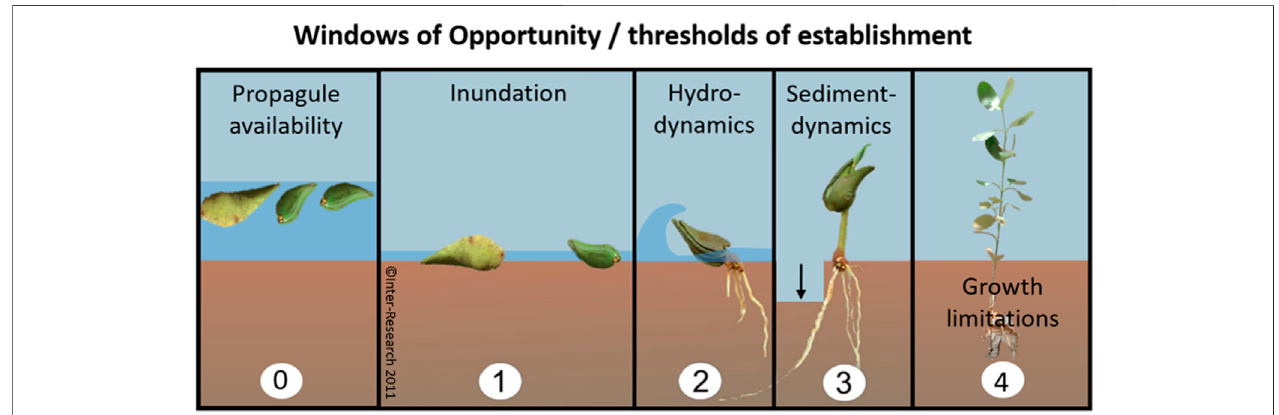
FIGURE1| Windowsofopportunitythatpropagulesshouldencounter(orthresholdofestablishmentthatpropagulesshouldovercome)beforetheycancolonizea site. EMR makes use of measures that extend the window of opportunity for natural establishment (0 – 3) . Mangrove planting is either aimed at overcoming propagule limitation (0) or at skipping the thresholds of propagule establishment (1 – 3) by using larger seedlings or saplings that would, to a certain extent, be able to withstand conditionsthataretooharshforsmallerseedlings.Finally,saplingsneedtoovercomelimitationsofgrowth (4) suchaspredation,diseaseorotherstressorstogrow into reproductive young trees ( panels 0 and 4 are additions to Balke et al. (2011) ’ s Windows of Opportunity fi gure).